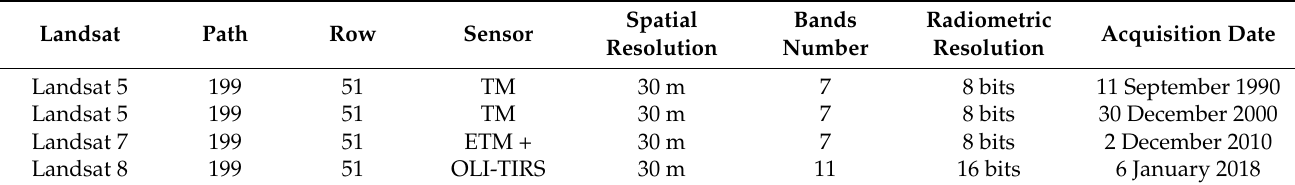
Table 1. Characteristics of remotely sensed